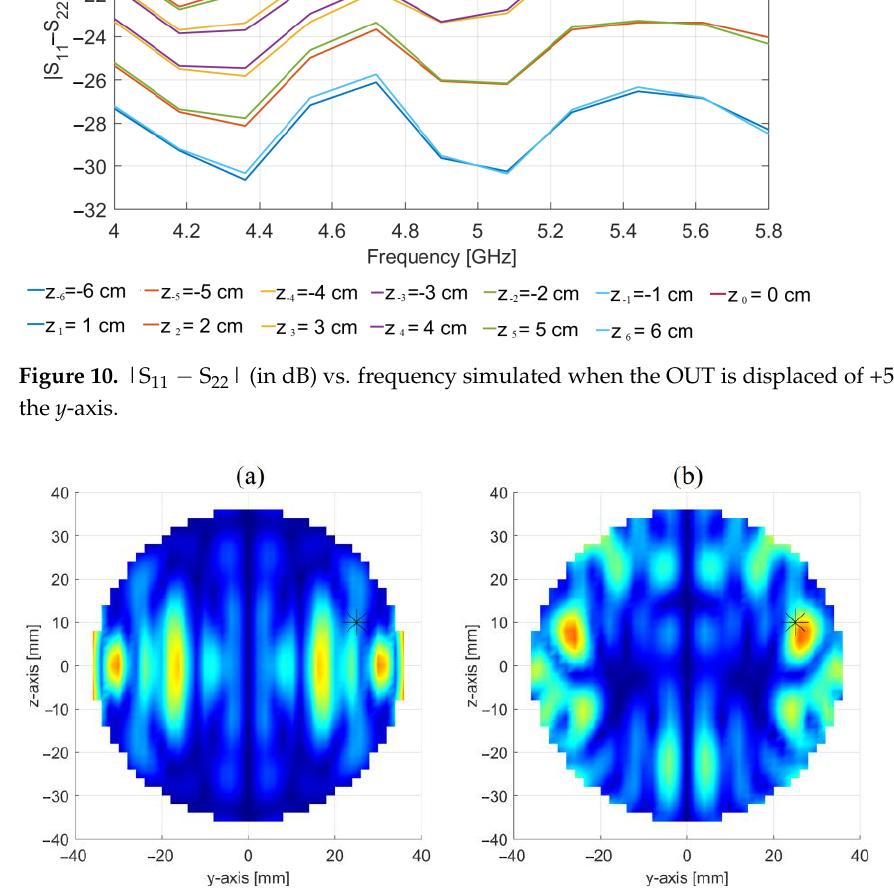
Figure 11. Reconstruction of the inclusion when the OUT is displaced of +5 mm along the y -axis: ( a ) data not calibrated; ( b ) data calibrated according to (5). (Stars give the position of the inclusion).